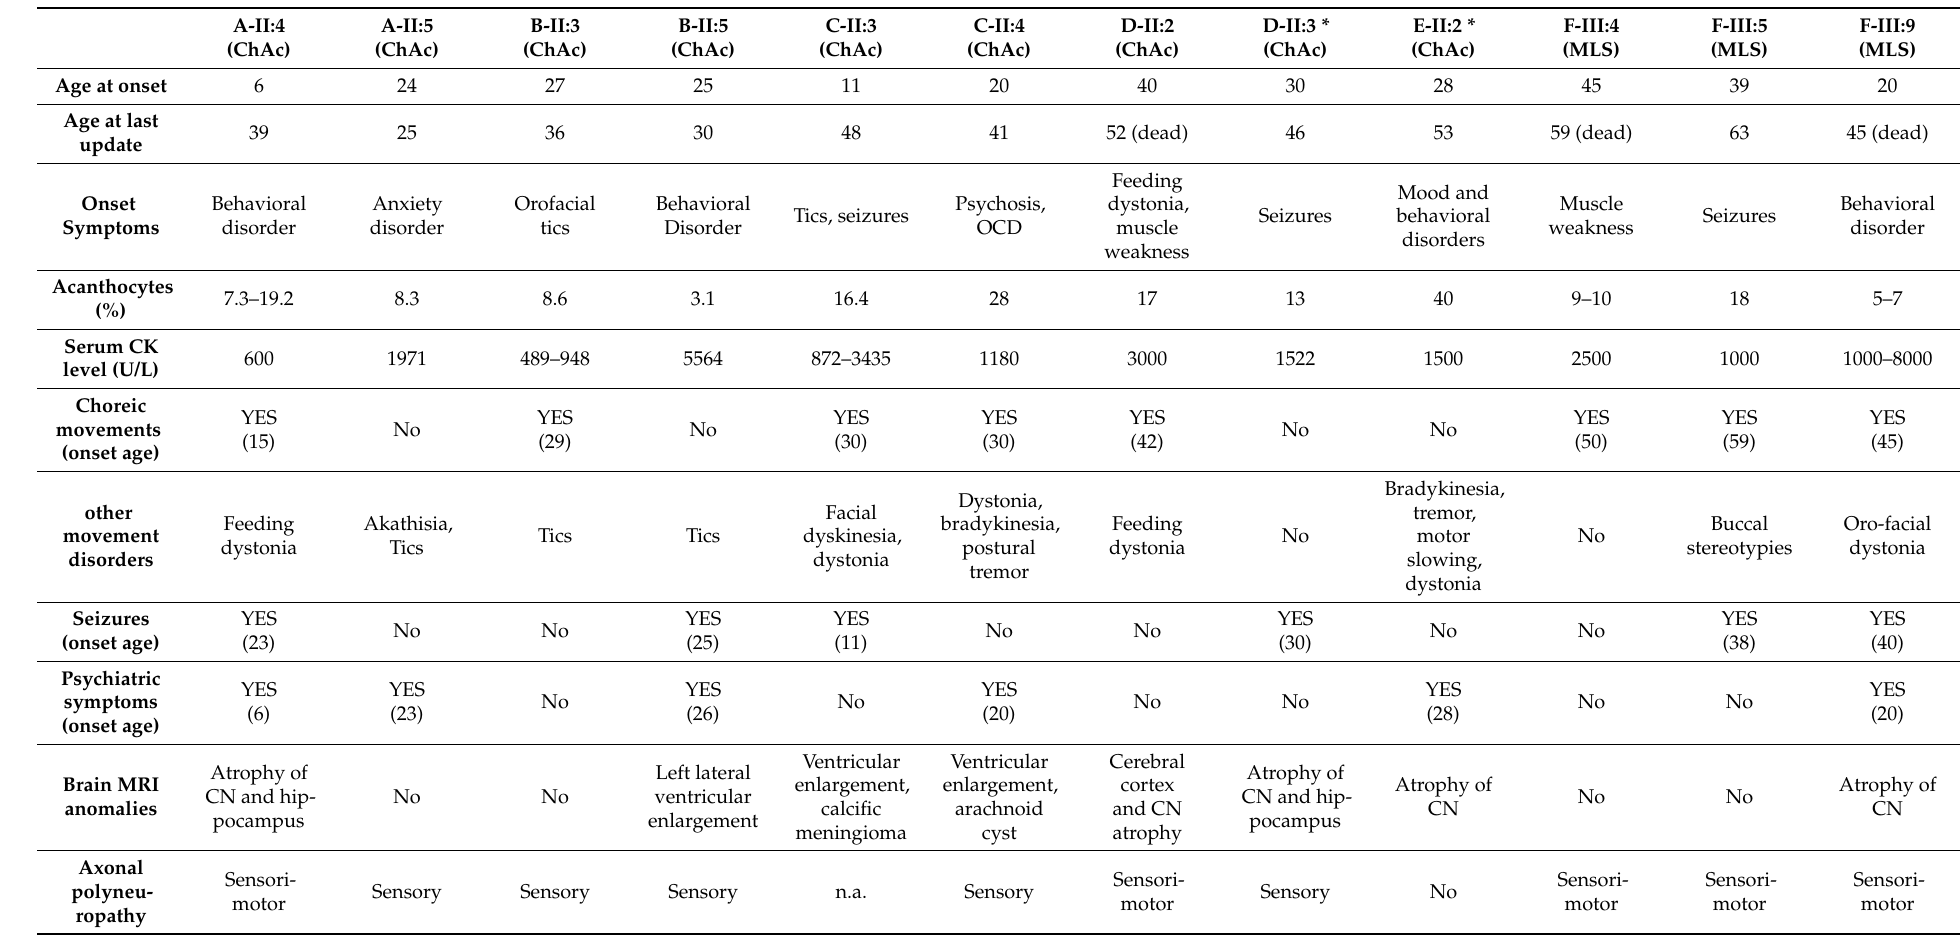
Table 1. Main clinical, laboratory and histological features. Acanthocytes: percentage of acanthocytes on peripheral blood smear; Serum CK level: normal range 60–190 U/L; OCD: obsessive-compulsive disorder; CN: caudate nuclei; LL: lower limbs; MUP: motor unit potential; ChAc: chorea-acanthocytosis; MLS: X-linked McLeod syndrome; n.a: not available. * previously reported by Peluso et al.